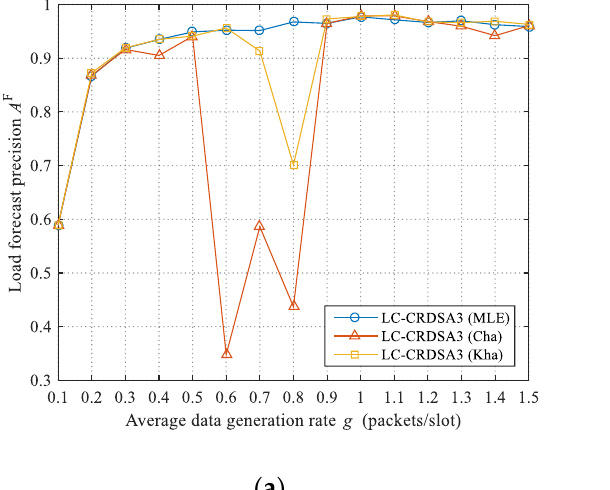
Figure 4. Load forecast precisions and throughput under the three load estimation algorithms: ( a ) Load forecast precisions under the three algorithms; ( b ) Throughput under the three algorithms.